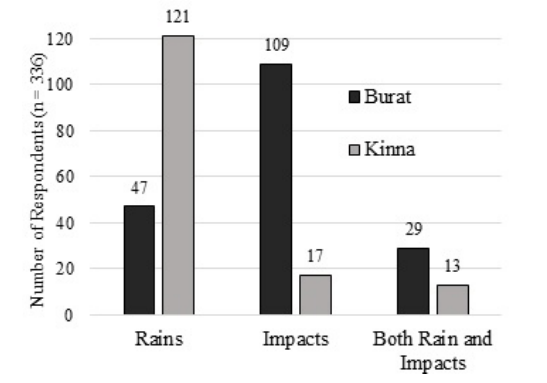
Fig. 3. Definition of drought by survey